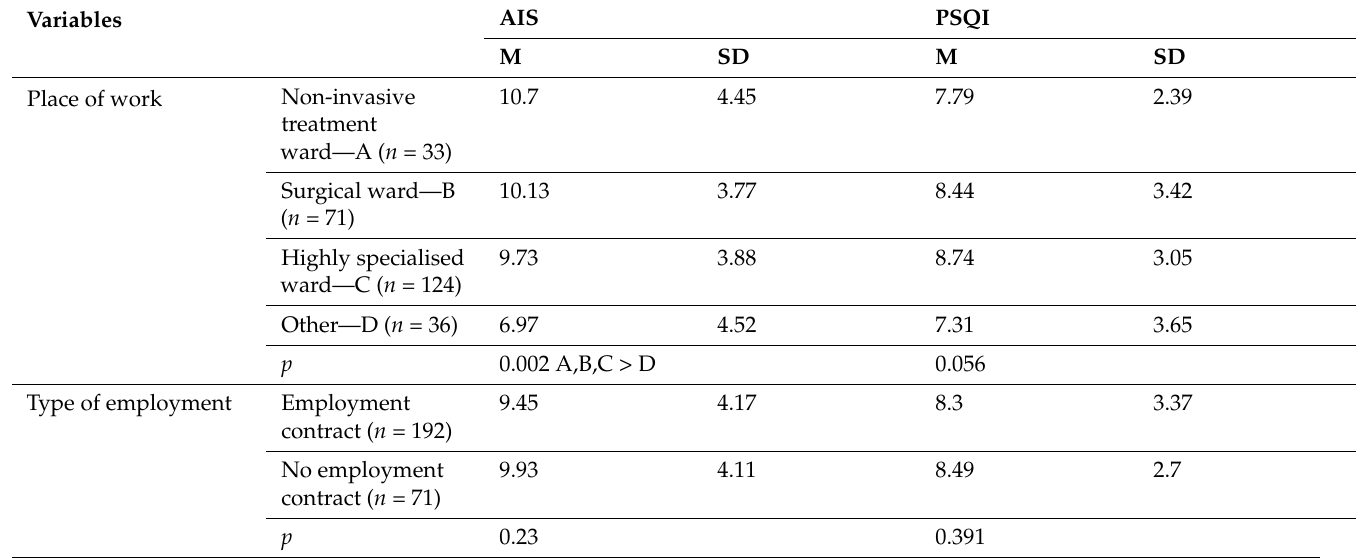
Table 7. The effect of the work-related variables on the occurrence of sleep